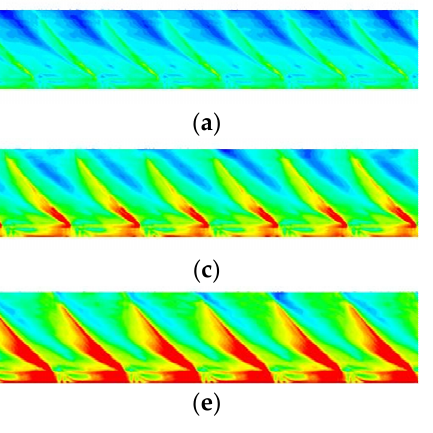
Figure 21. Velocity of the rotor blade tip at different rotating speeds (( a ) 2000 rpm; ( b )2600 rpm; ( c ) 3200 rpm; ( d ) 3600 rpm; ( e ) 4000 rpm; ( f ) legend).